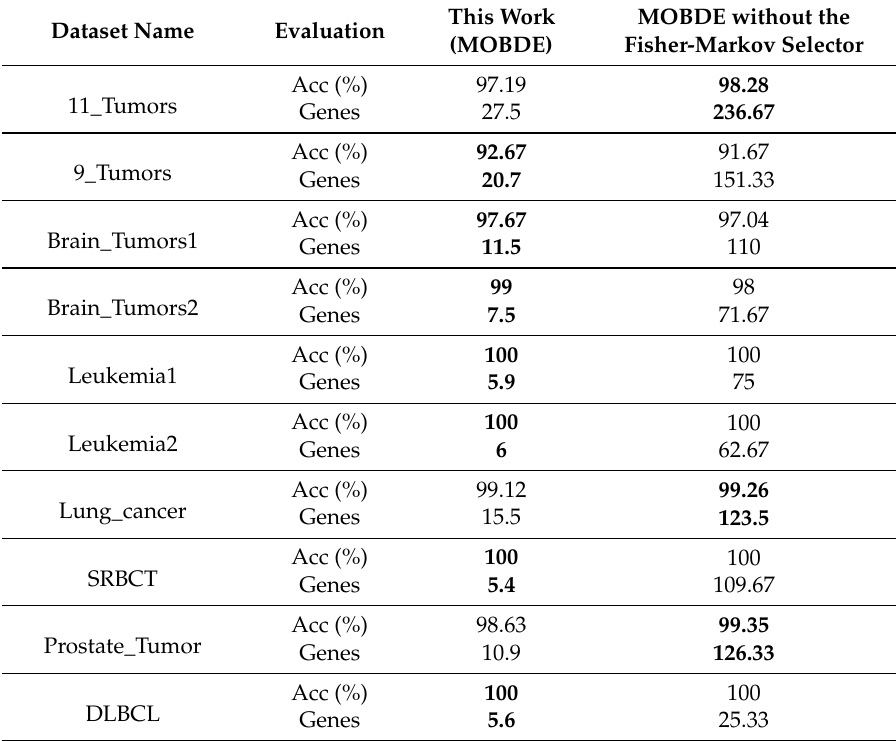
Table 6. Comparative experimental results of the binary differential evolution algorithm with and without the Fisher-Markov selector.